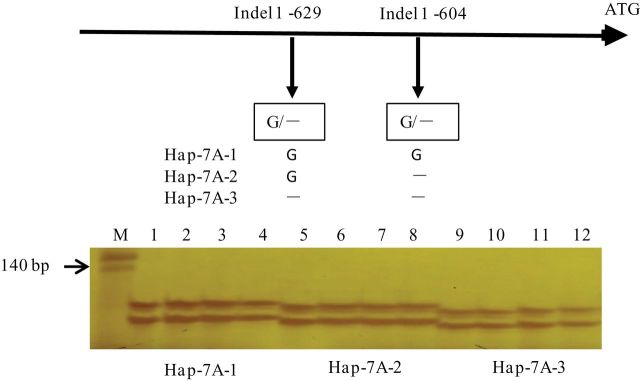
Marker development and polymorphism of different cultivars on 6% denaturing polyacrylamide gels. M, marker; 1, LM14; 2, QCM; 3, WSB; 4, NQ4; 5, NY188; 6, BN6; 7, AM6; 8, PY27; 9, SJZ8; 10, YZ1; 11, S4185; 12, YM18.